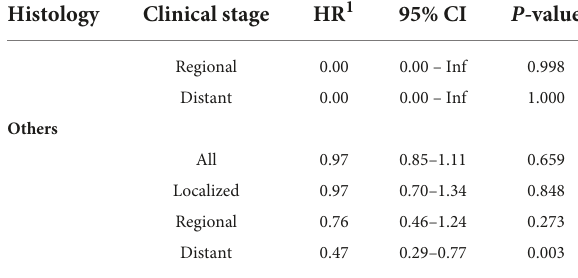
TABLE 6 Subgroup analysis of fatal HD among patients with sarcoma by histology and clinical